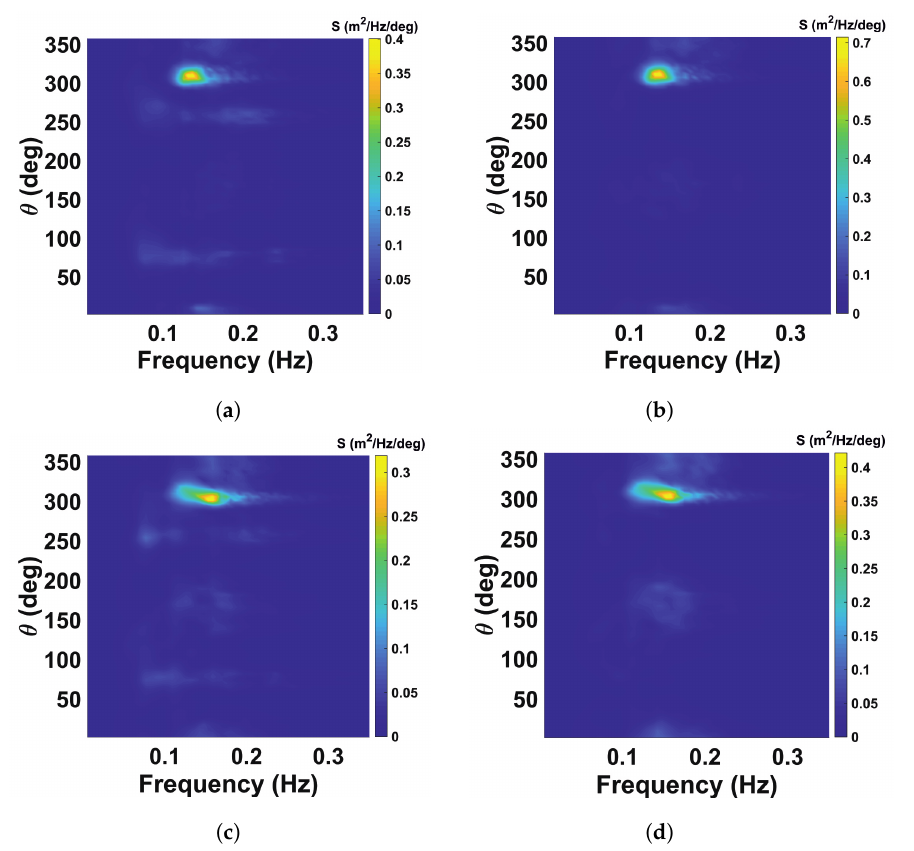
Figure 9. WaMoSII frequency spectra for reliable data marked as unreliable one (upper row) and reliable data (bottom row) before and after filtration. The left column shows the standard results including artefacts of the interferences. In right column the corresponding spectra after interference removal are shown. Streaks spectrum is still noticeable in its theoretical location. Right column panels demonstrate necessity of the streak filtration (weak streak patterns are efficiently removed). ( a ) Reliable data marked as one with insufficient sea clutter before filtering. ( b ) Reliable data marked as one with insufficient sea clutter after streaks’ filtration. ( c ) Reliable data marked correctly before filtration. ( d ) Reliable data marked correctly after streaks’